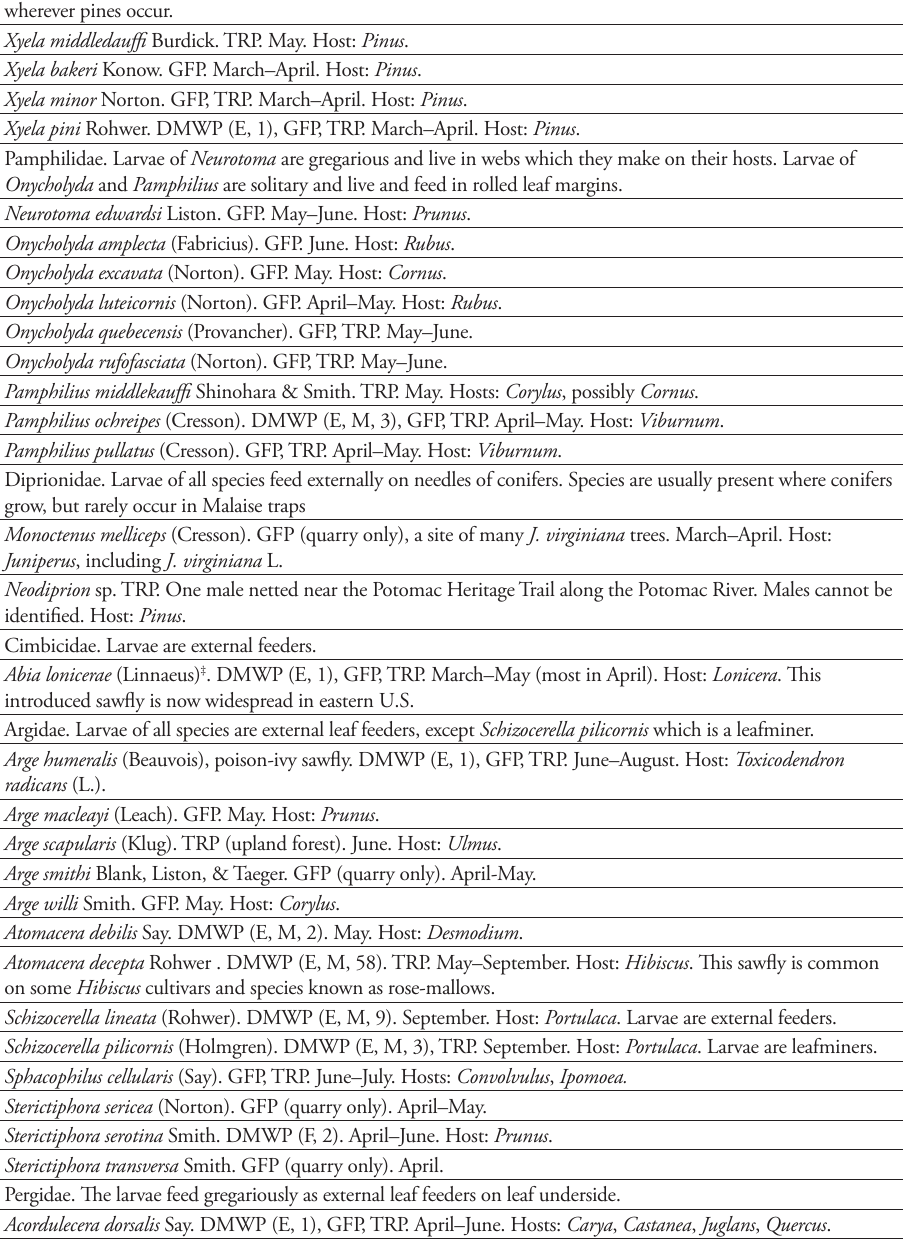
Table 1. An annotated list of sawfly taxa of GWMP with fight periods based on our samples, parks in which species occurred, known species host plants, and other notes †